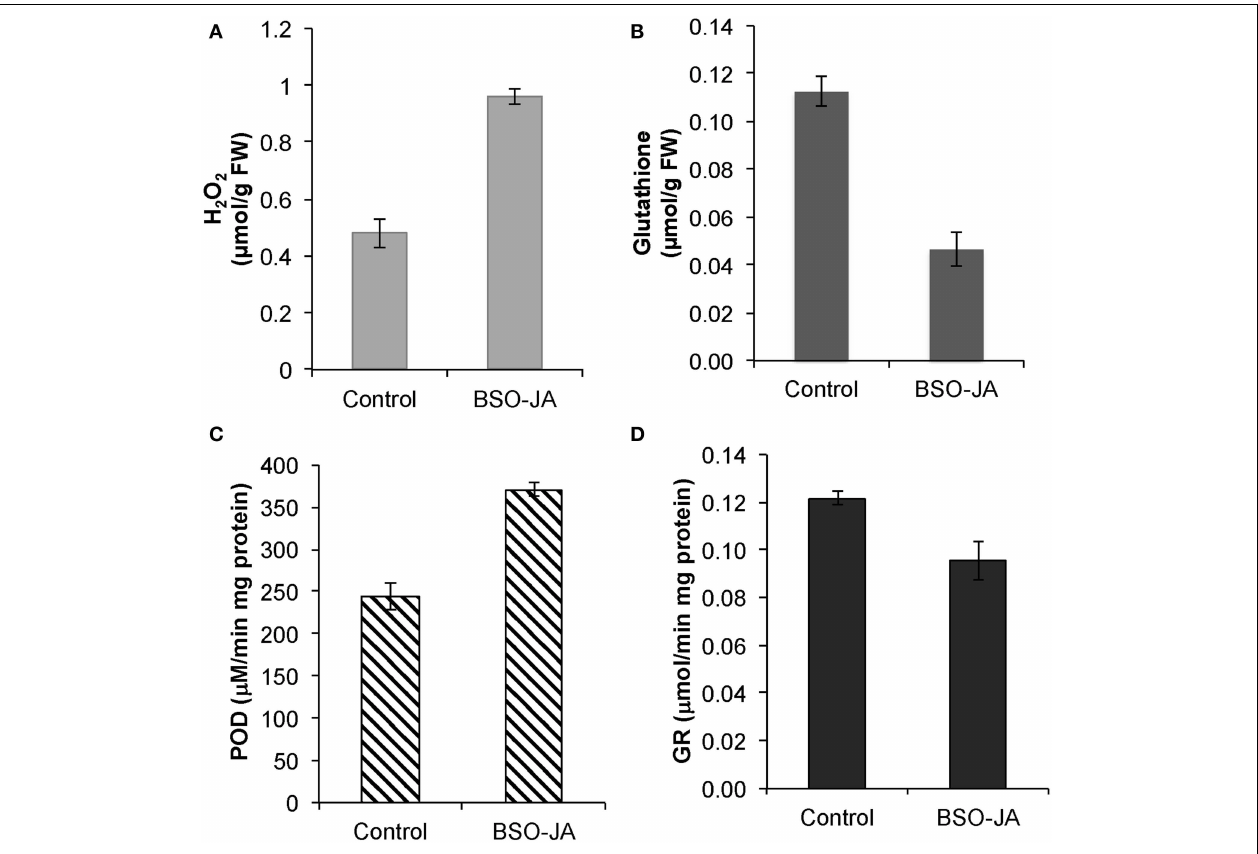
peroxidase (POD) and (D) glutathione reductase (GR). The elicitor was added to 13 days-old root cultures (exponential growth phase). Error bars indicate standard deviation from the mean ( n = 3